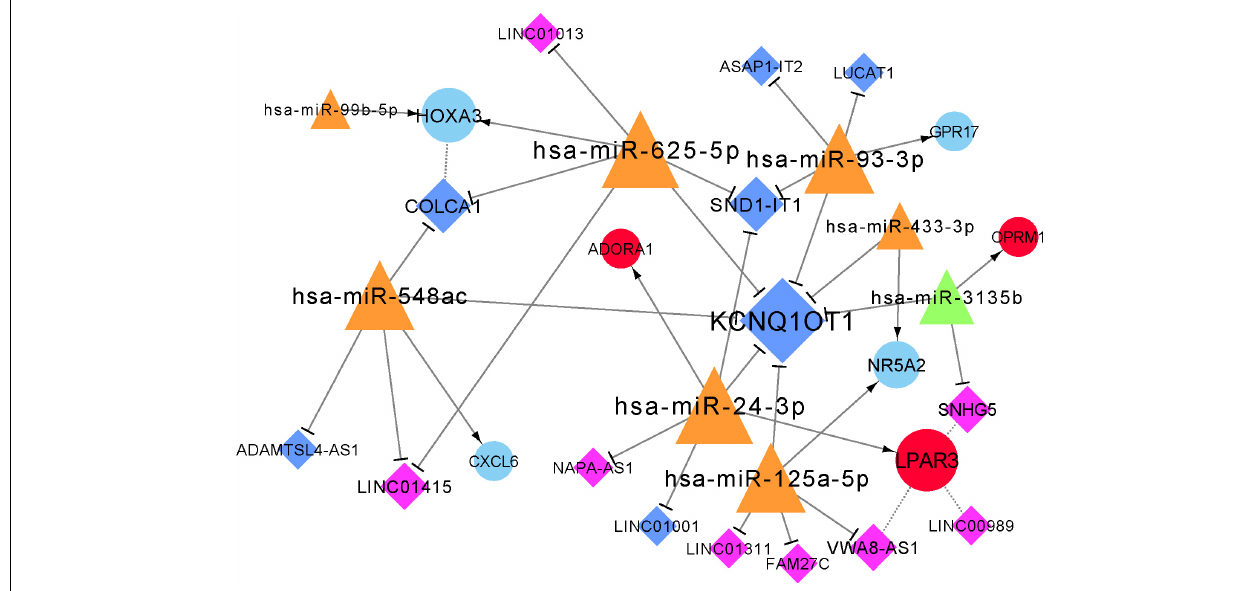
FIGURE 5 | Constructed lncRNA-miRNA-mRNA network. Red circular nodes are upregulated mRNAs and blue circles are downregulated mRNAs. Dark-blue diamonds represent downregulated lncRNAs and purple diamonds represent upregulated lncRNAs. Orange triangles represent upregulated miRNAs and green triangles are downregulated miRNAs. Dotted lines demonstrate positively-correlated interactions of mRNAs and lncRNAs, straight lines with arrow represent interactions between miRNAs and mRNAs, and a straight line with T arrow means lncRNA-miRNA interaction. The size of node represents its degree.